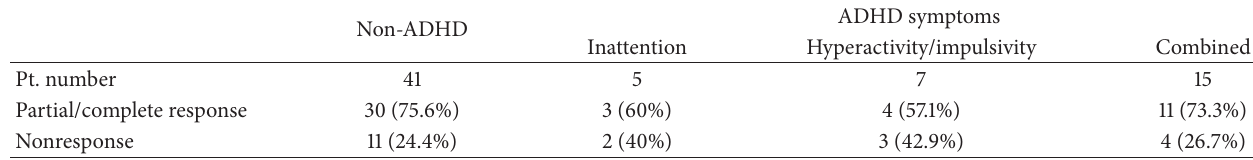
Table 3: The response of desmopressin for total subjects categorized by ADHD type (all 𝑃 > 0.05 compared to non-ADHD).